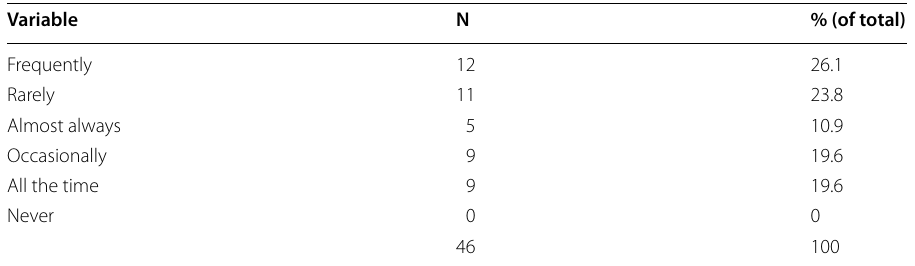
Table 6 Academics’ proficiency levels regarding using telepresence robots’ technology Proficiency levels Number and